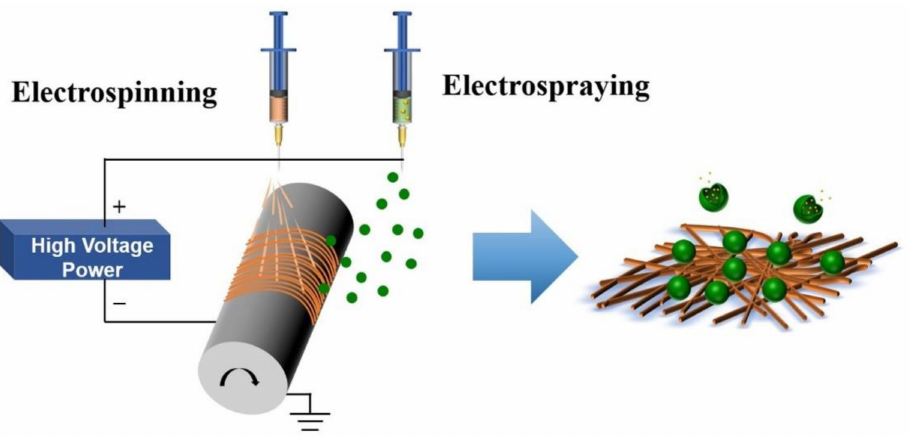
Figure 12. Fibrous drug delivery system prepared by electrospinning and electrospraying. Repro- duced with permission [11]. © 2021 Elsevier Inc. All rights